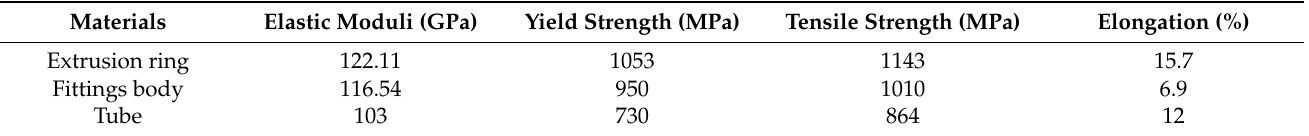
Table 1. Material mechanical properties for the joint component.